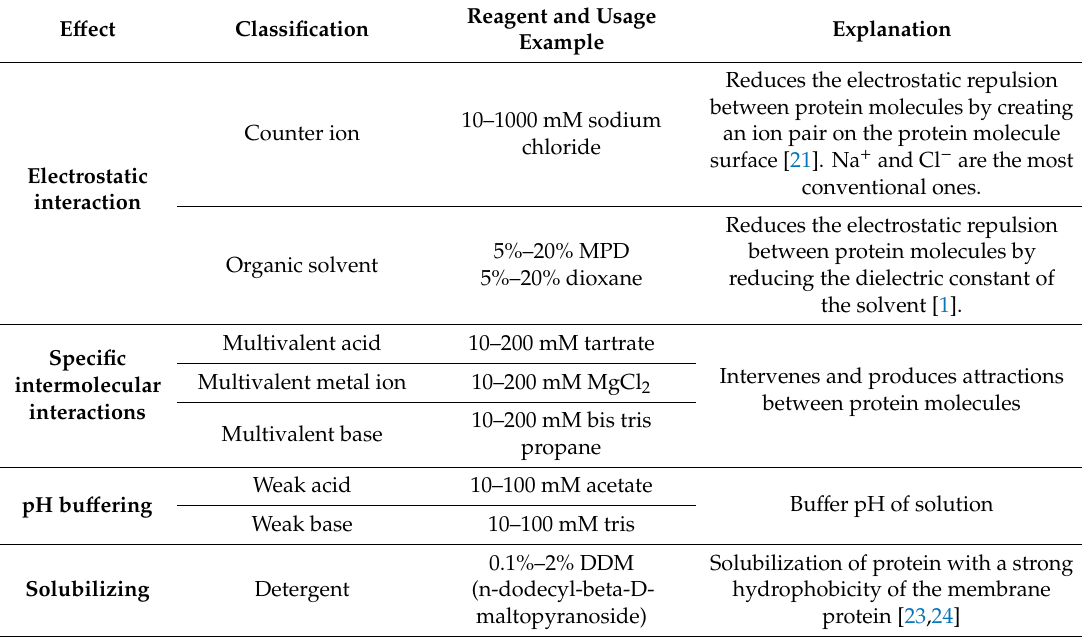
Table 1. Typically used additives in crystallization